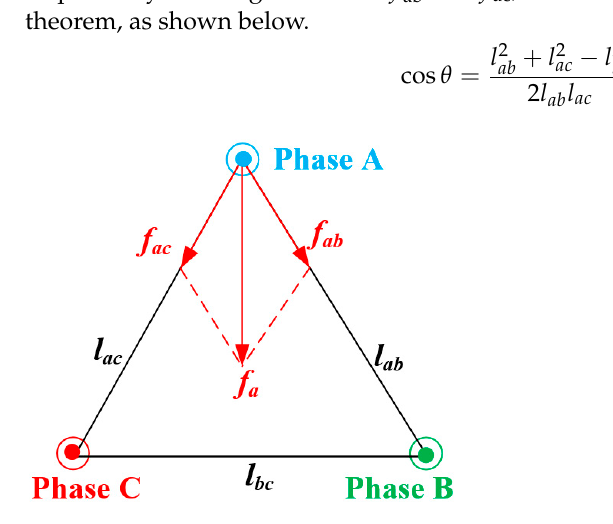
Figure 7. Force analysis of three phase insulated type GIS.